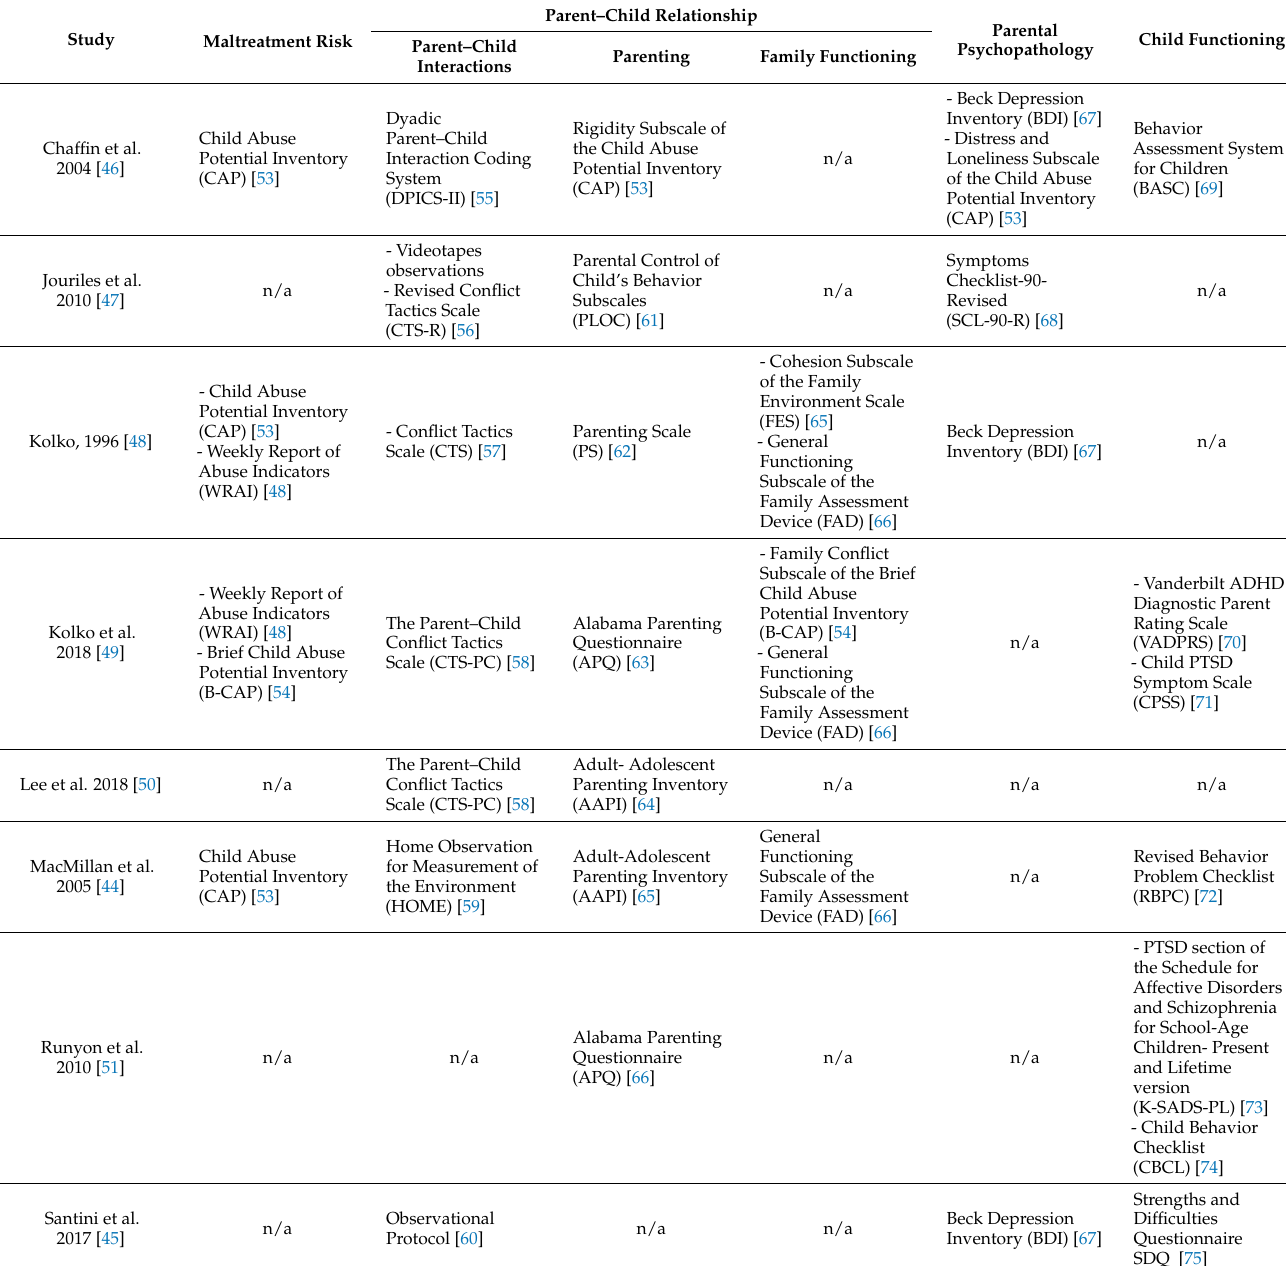
Table 2. Assessment measures of secondary